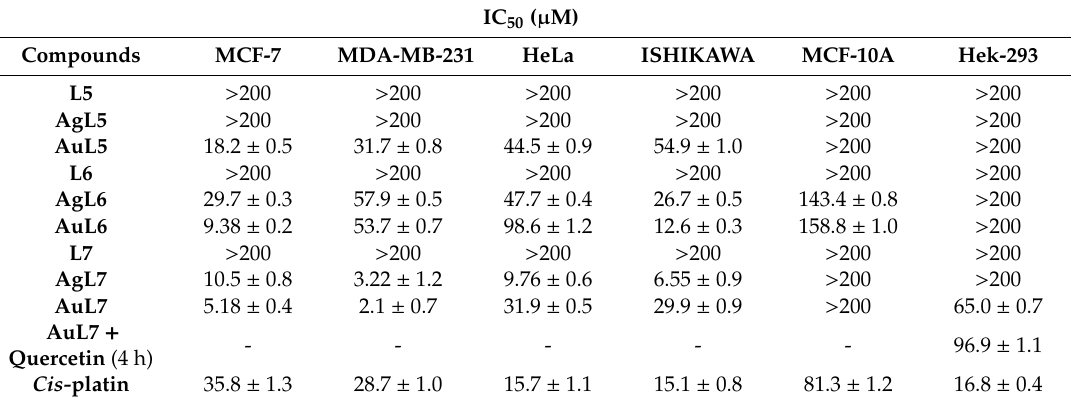
Table 1. IC 50 values of L5 , L6 , and L7 metal complexes and Cisplatin, expressed in µ M. The means ± standard deviations are